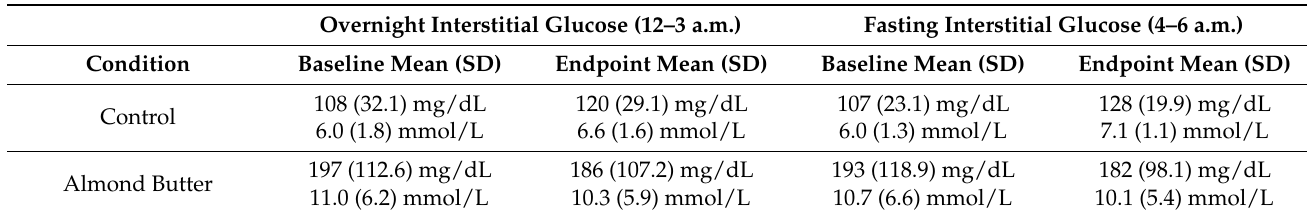
Table 2. Mean overnight and fasting interstitial glucose at baseline and end of study. Overnight Interstitial Glucose (12–3 a.m.) Fasting Interstitial Glucose (4–6 a.m.)